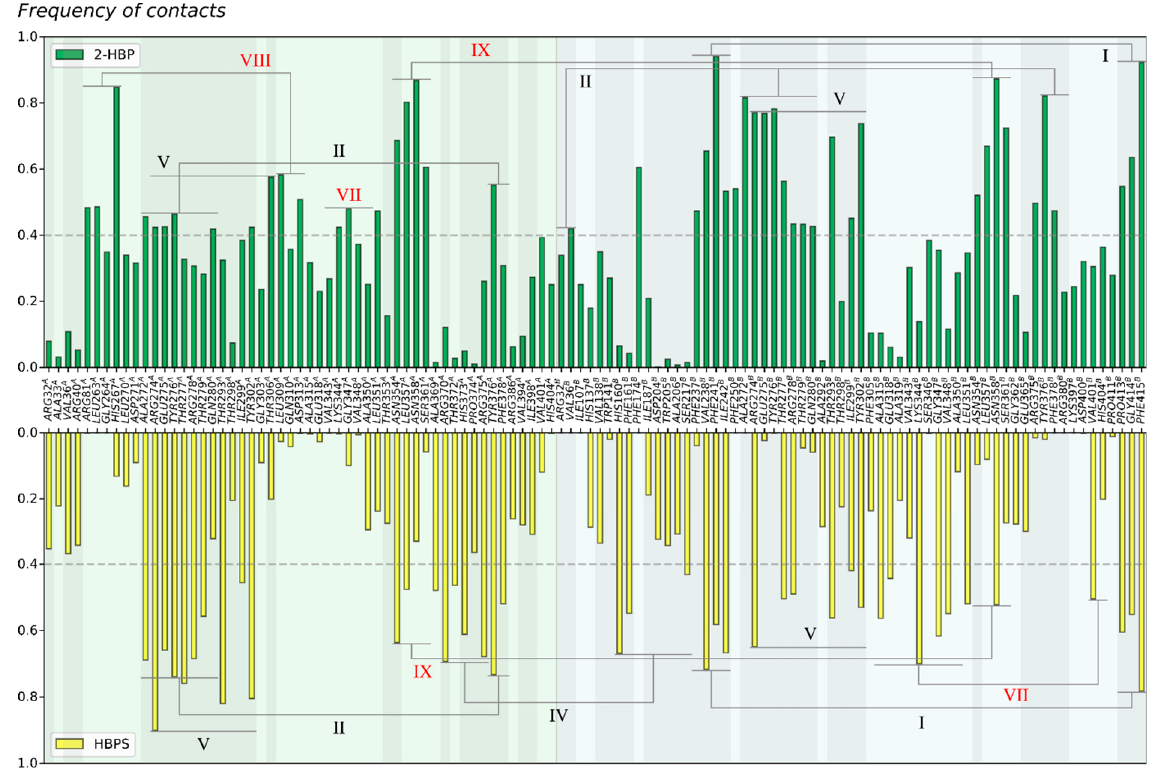
Figure 2. Summary bar plot with the frequency of contacts between 2-HBP (in green) and HBPS (in yellow) with DszC residues at a minimum distance of 3.5 Å, considering all the eight 200 ns MD simulations. The detailed individual plots are shows in Figures S7–S10. The frequency shown corresponds to the maximum frequency of contacts for 2-HBP or HBPS—only residues that contact for more than 20% of the simulation time are shown.